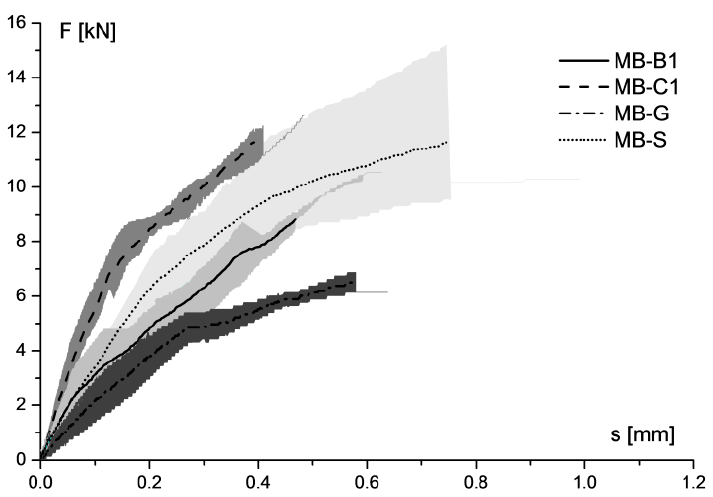
Figure 5. Average load–slip curves of shear bond tests on clay masonry unit.